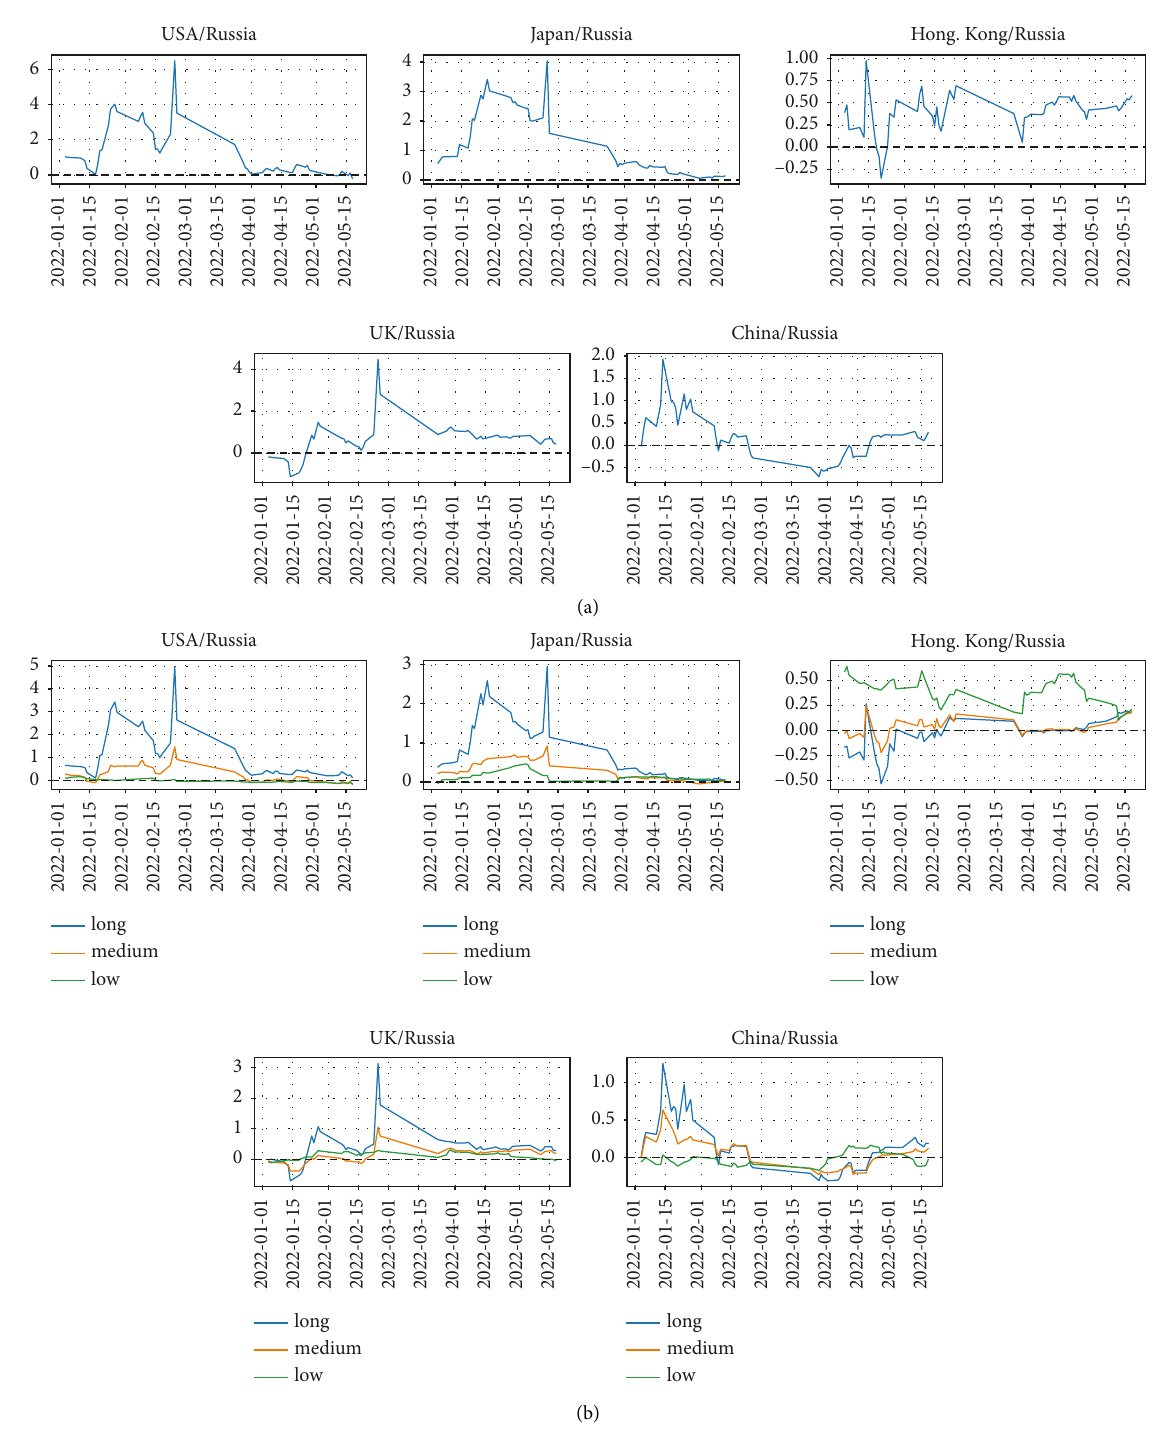
Figure 3: Net pairwise spillovers and frequency decomposition. (a) Net pairwise spillovers. (b) Time-frequency decomposition of the net pairwise